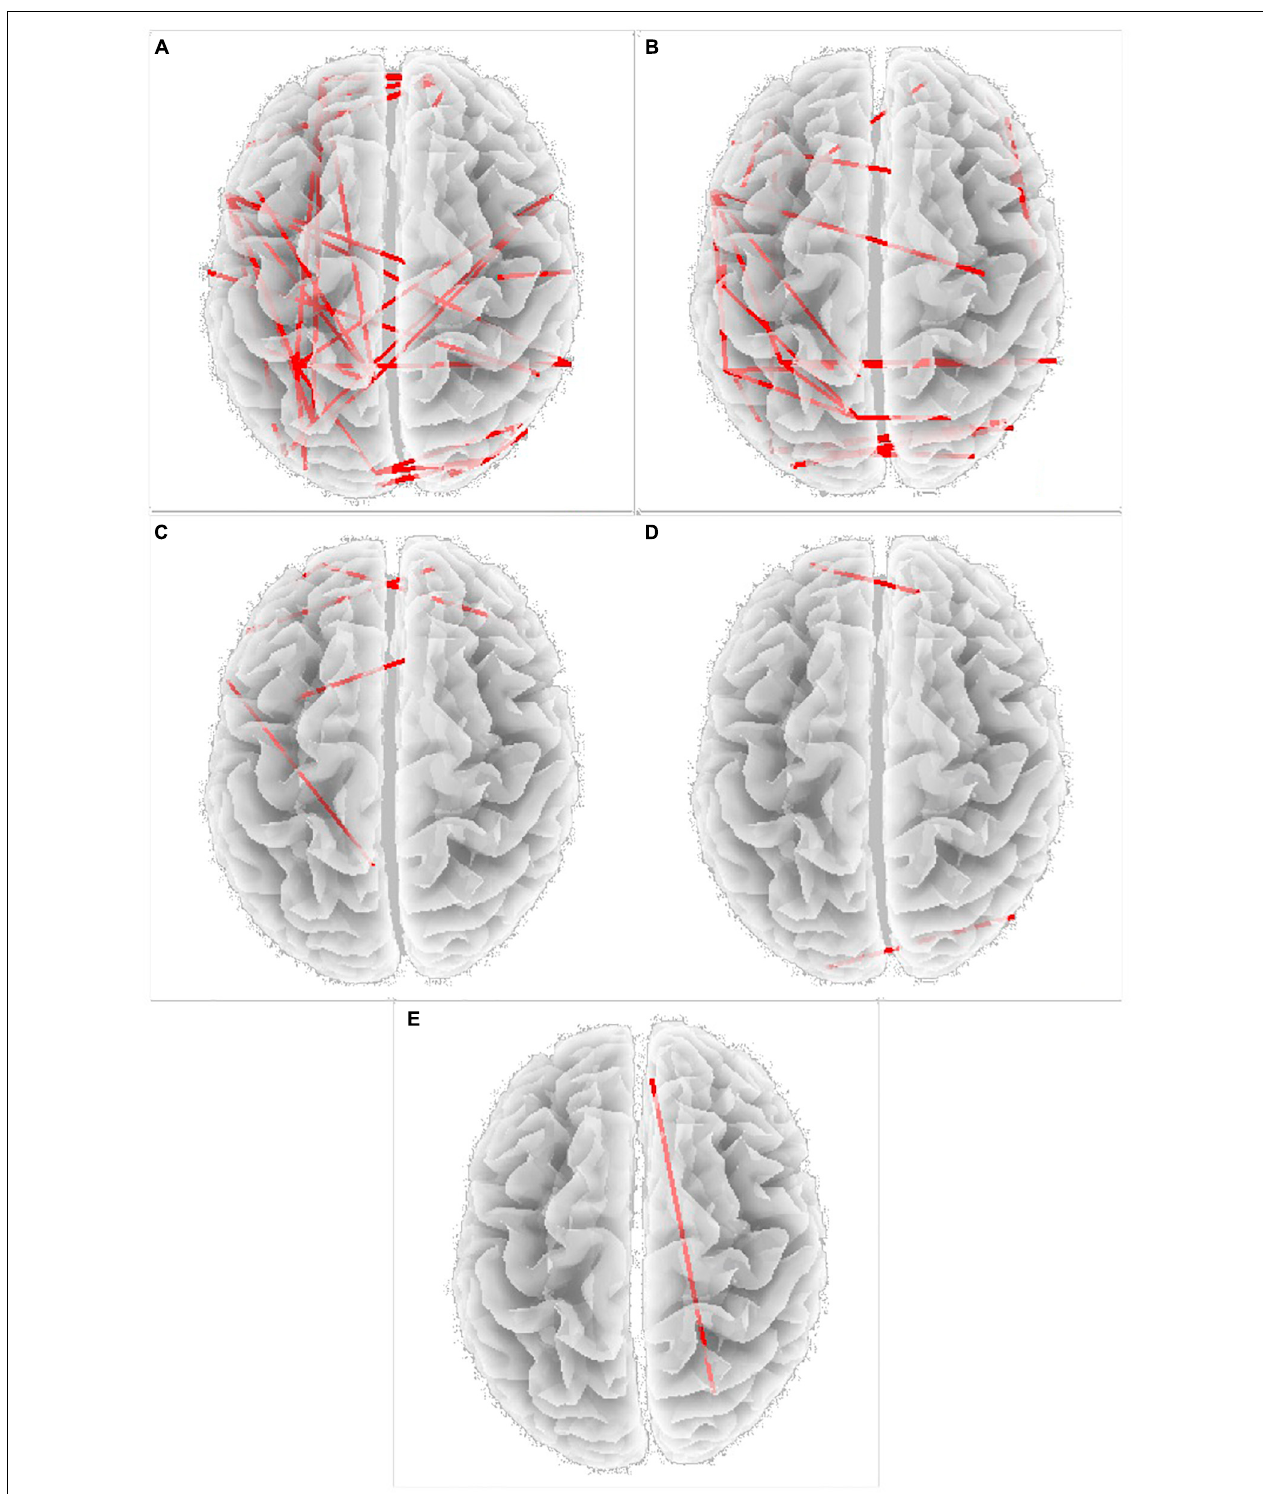
FIGURE 2 | Increase in “lagged phase synchronization” (red lines) in (A) Delta band; (B) Alpha 1 band; (C) Alpha 2 band; (D) Beta 2 band; (E) Beta 3 band, Specific BAs involved are reported in Table 3 .